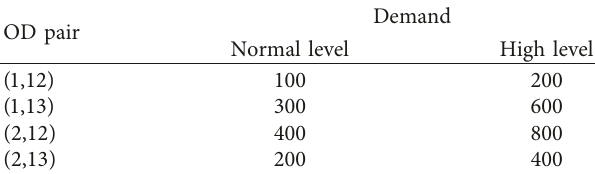
Table 5: Travel demand of OD pairs. OD